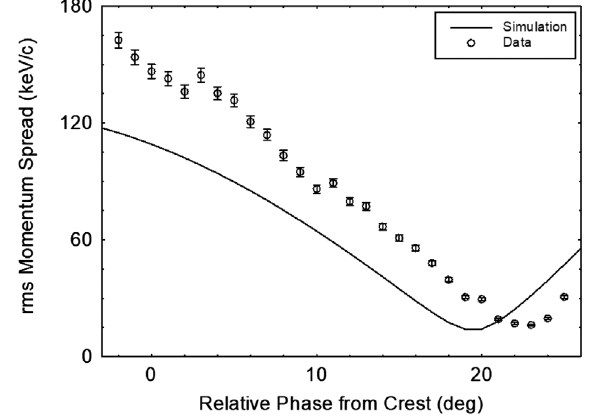
FIG. 34. Momentum spread versus phase (from crest) for the gun in the CLARA position with the linac switched on at a constant phase and power level.